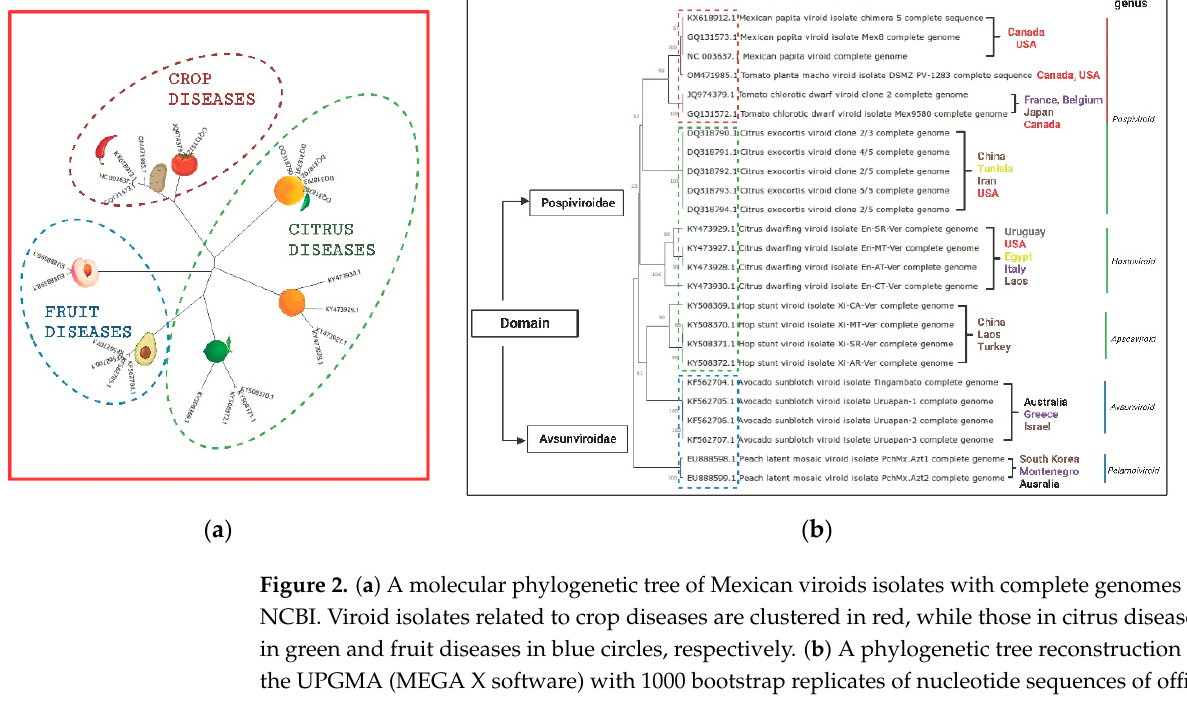
Figure 2. ( a ) A molecular phylogenetic tree of Mexican viroids isolates with complete genomes in the NCBI. Viroid isolates related to crop diseases are clustered in red, while those in citrus diseases are in green and fruit diseases in blue circles, respectively . ( b ) A phylogenetic tree reconstruction using the UPGMA (MEGA X software) with 1000 bootstrap replicates of nucleotide sequences of officially reported viroids in Mexico, their relationship with isolates from other countries are colored by the continent of distribution, red: North America; gray: South America; purple: Europe; yellow: Africa; brown: Asia; black: Oceania in Pospiviroidae and Avsunviroidae